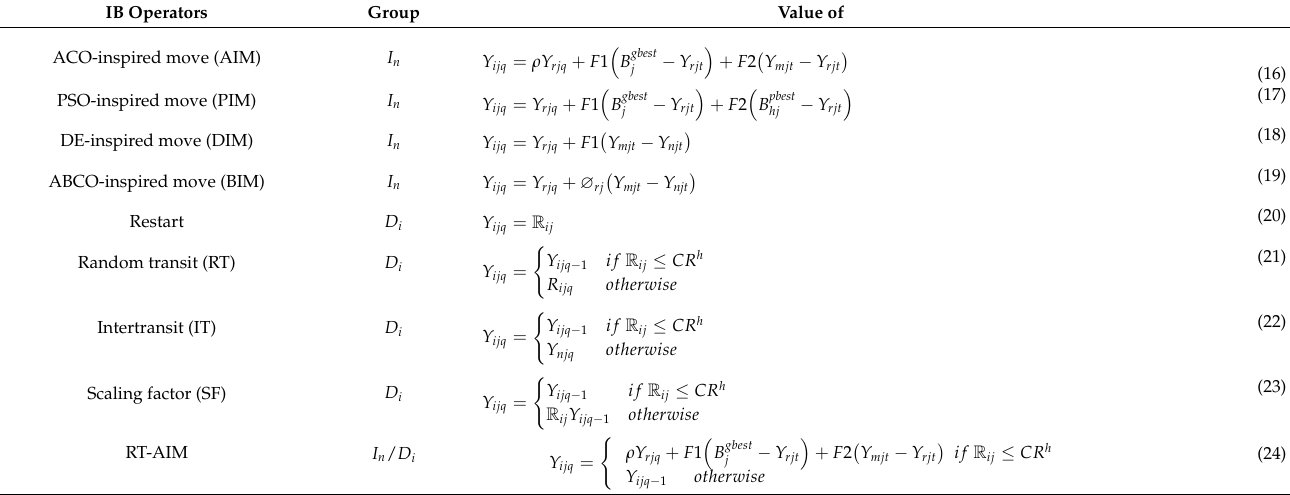
Table 8. Intelligence box